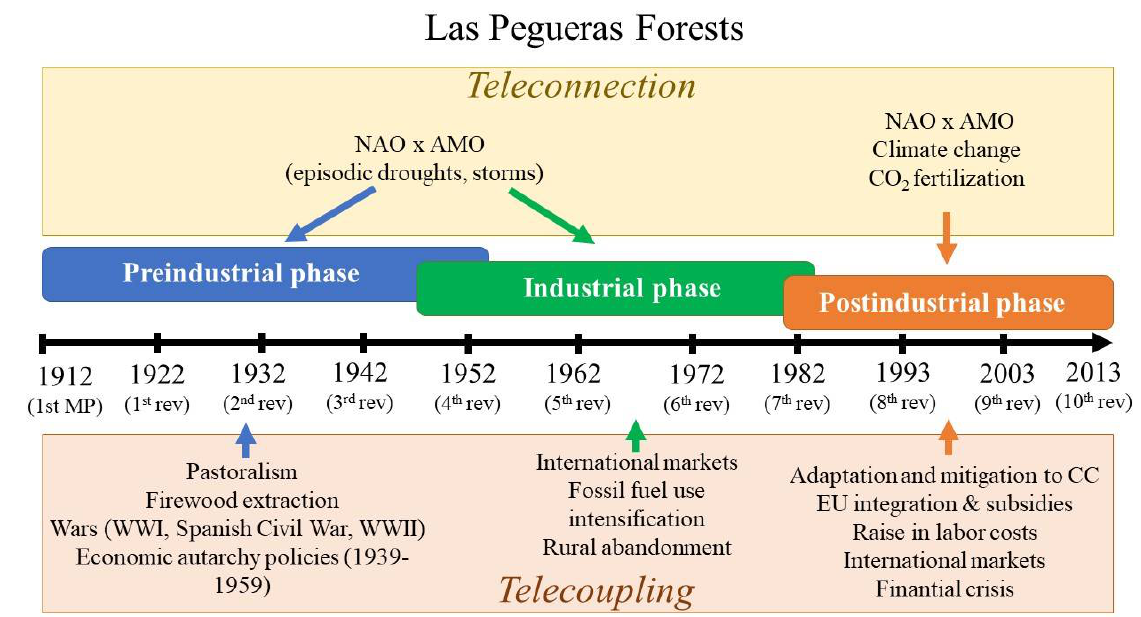
Figure 2. Flow chart of Las Pegueras Forest and the historical telecoupling framework. MP: Management plan. Rev: revision of the management plan.